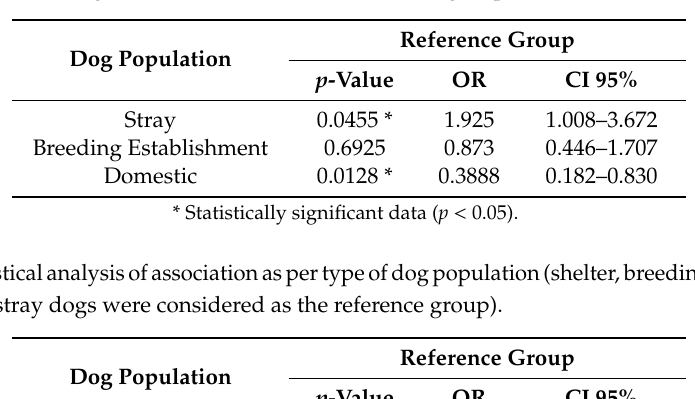
Table A4. Statistical analysis of association as per type of dog population (stray, breeding establishment and domestic; shelter dogs were considered as the reference group).